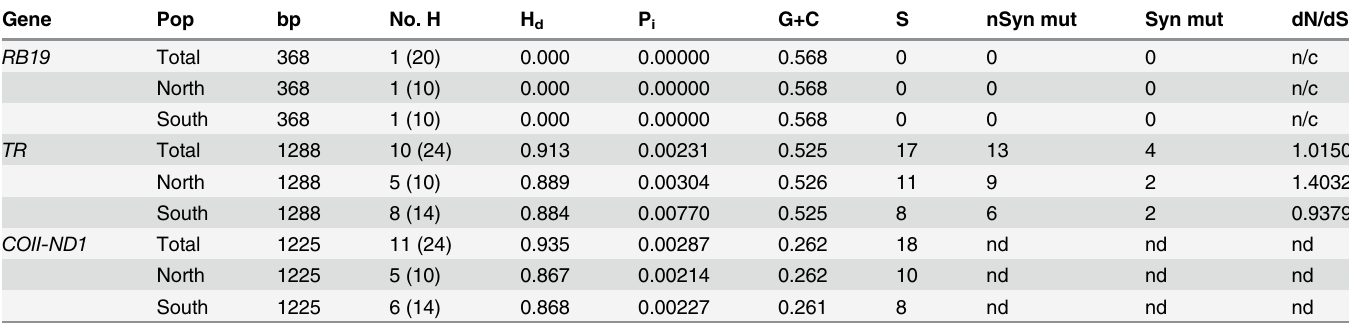
Table 4. Comparative diversity indices for Trypanosoma cruzi TcI sequences obtained from Triatoma protracta specimens collected in California, USA 1 . The data is represented for the overall combined (Total) populations, as well as at the regional population level (North = Vallecito; South = Escondido and Los Angeles area).